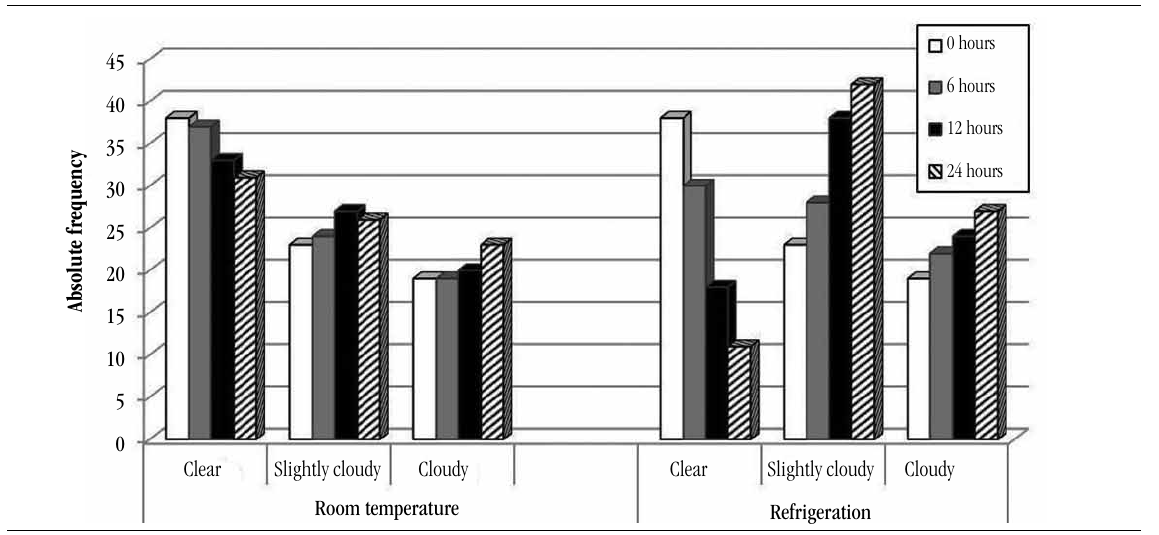
figurE 2 – Features of urine samples kept at room temperature and refrigerated storage at 2 to 8ºC for up to 24 hours ( n =